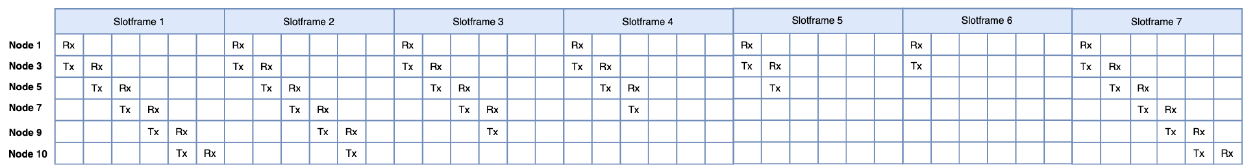
Figure 2. An example of timeslot allocation of the proposed